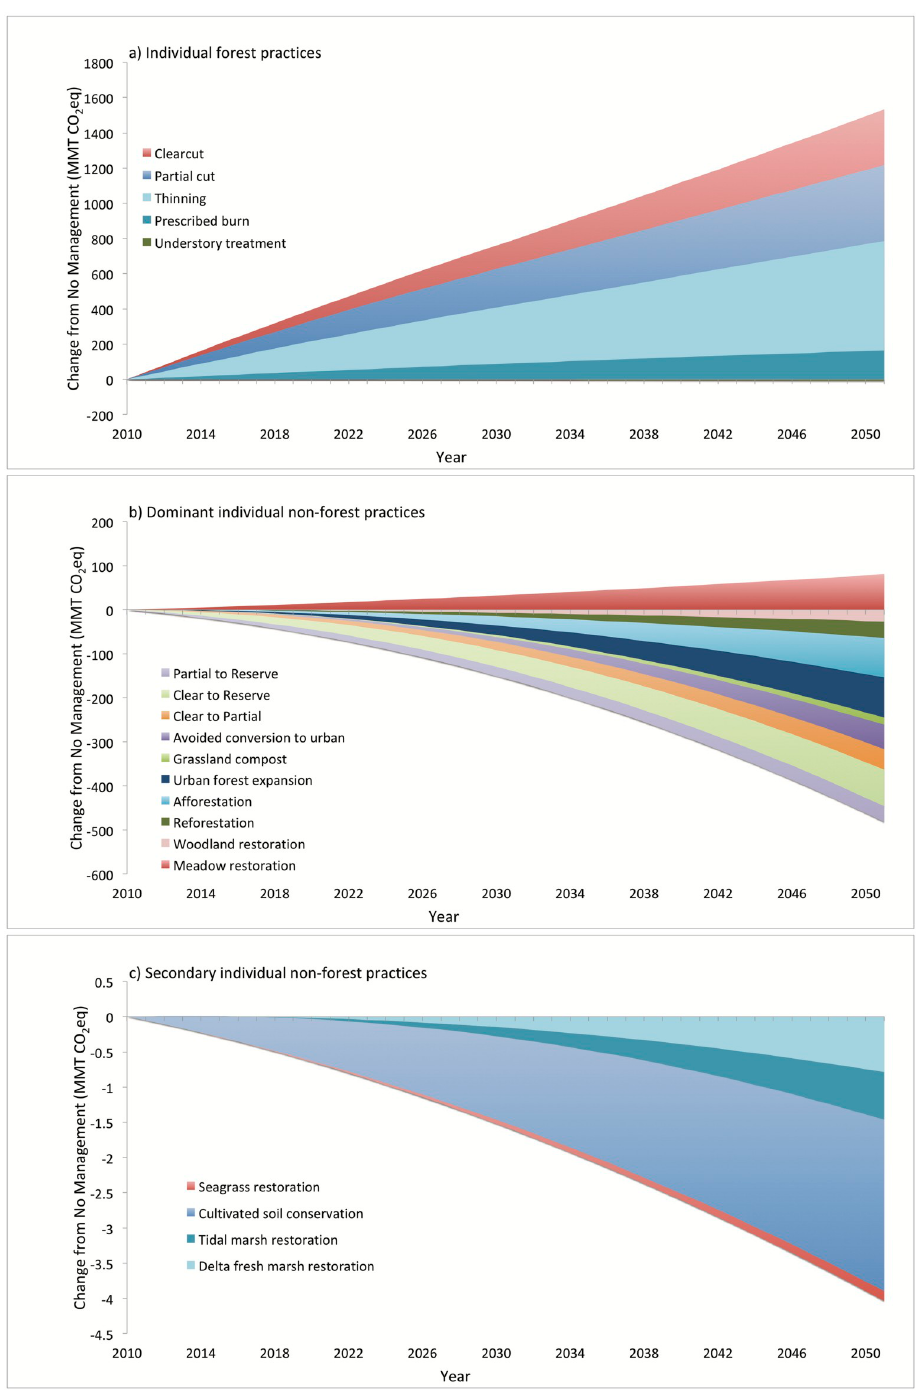
Fig 8. Cumulative benefits (negative) or costs (positive) of individual practices in isolation. Note that a) forest management effects are an order of magnitude larger than b) most practices and two orders of magnitude larger than c) water- and Cultivated-related